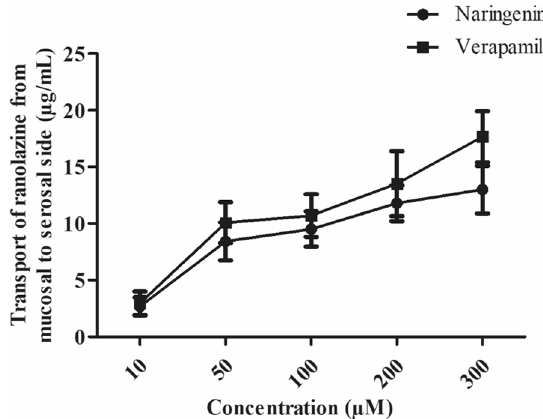
Fig. 2 Ranolazine plasma concentration levels in SDS and MDS with and without naringenin ( n multi-dose